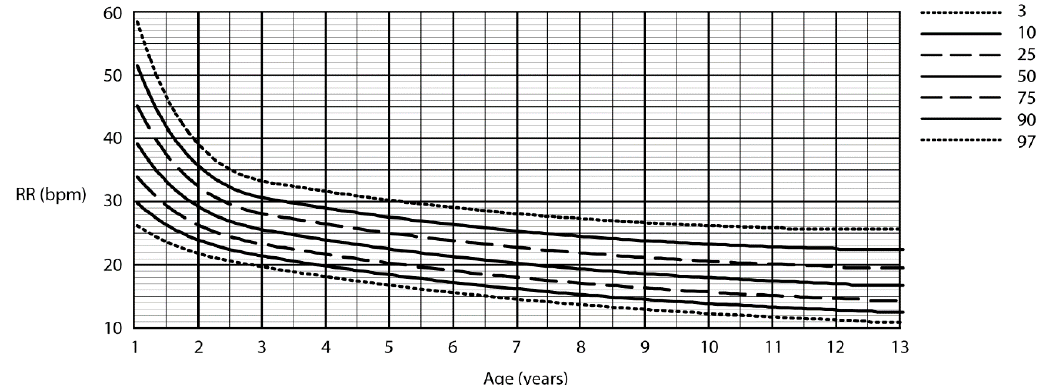
Figure 3. Respiratory rate centile chart in awake children (centiles—3rd, 10th, 25th, 50th, 75th, 90th, 97th).